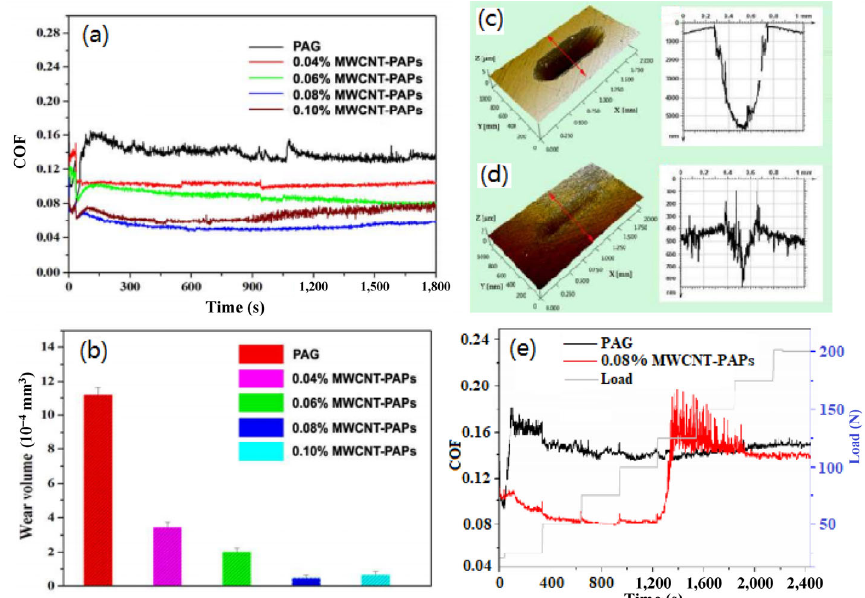
Fig. 8 (a) COFs and (b) wear volumes lubricated by MWCNT-PAPs with different concentrations (50 N, 25 Hz, and 150 °C); (c, d) three-dimensional (3D) optical microscopic images of the disc worn surfaces lubricated by polyalkylene glycol (PAG) and PAG with 0.08 wt% MWCNT-PAPs, respectively; (e) variations of COF with time under different loads (25 Hz, 150 °C). Reproduced with permission from Ref. [135], © Elsevier Ltd.